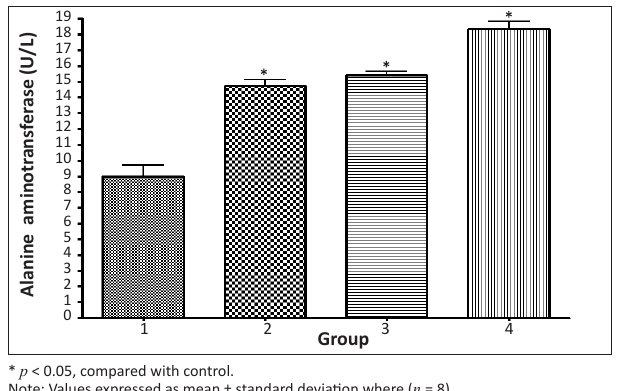
Figure 2: Effect of calcium hypochlorite on aspartate aminotransferase (AST) activity * p < 0.05, compared with control. Values expressed as mean ± S.D where ( n = 8). Asterisks indicate significant ( p <0.05) Note: Values expressed as mean ± standard deviation where ( n = 8). difference compared with control. FIGURE 2: Effect of calcium hypochlorite on aspartate aminotransferase activity.